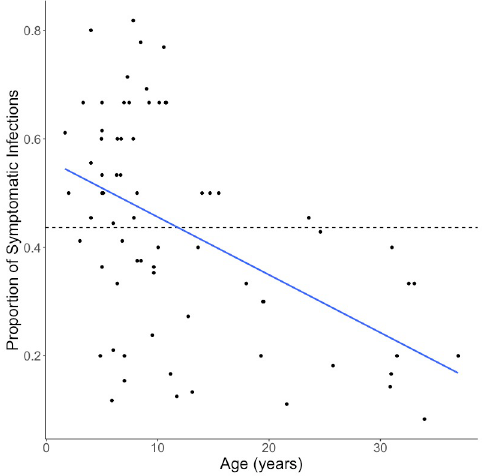
Fig 1. Relationship between proportion of symptomatic infections and age. Scatterplot, including linear regression line (blue), shows the relationship between the proportion of symptomatic infections per individual over the course of the study and age of the individual at enrollment. The dashed line shows median proportion of symptomatic infections, which was used to define the high and low immunity groups.